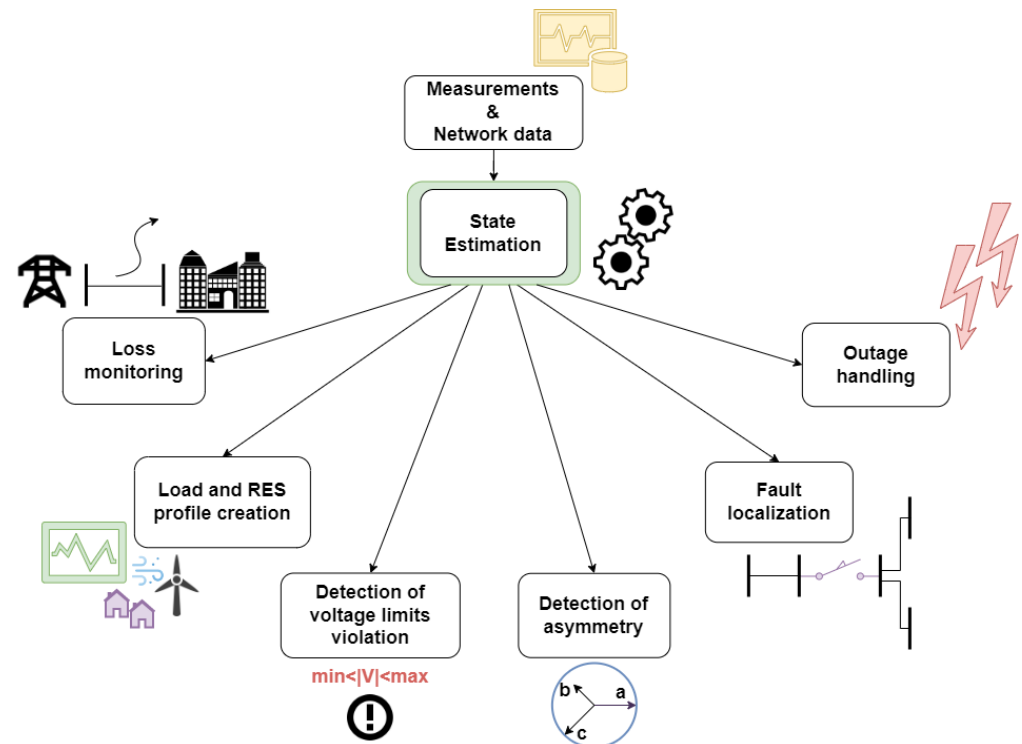
Figure 1. The value of DSSE for the DSO.